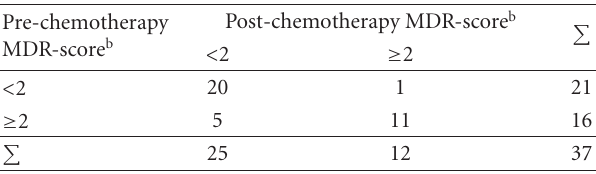
Table 5: Multiple drug resistance (Pgp expression) in 37 osteosar- comas in pre- and post-chemotherapy biopsies, respectively a . P value c = . 10.